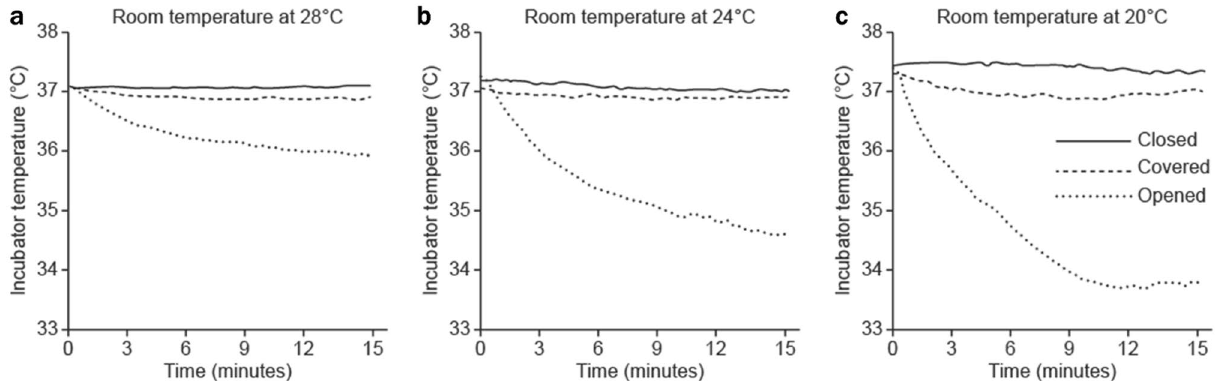
Figure 2. Representative graph of the temperature changes inside the transport incubator for the three snap- open access port conditions. Access port conditions are indicated as follows: solid lines, “closed” condition; dotted lines with wide spacing, “covered” condition; and dotted lines with narrow spacing, “opened” condition. The temperature inside the incubator at the start and end of the 15-min period of temperature measurement, respectively, for the three snap-open access ports conditions are as follows: ( a ) Room temperature at 28 ℃